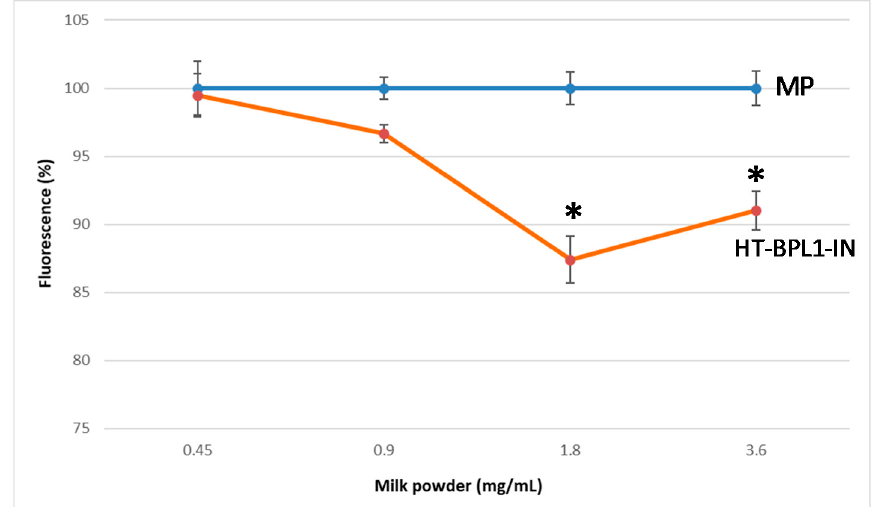
Figure 1. Milk powder supplemented with heat-treated BPL1 (HT-BPL1-IN), reduced fat deposition in C. elegans measured as fluorescence with red Nile, in a concentration-dependent manner. Worms were incubated for 3 days with increasing concentrations (abscissa) of milk powder alone (MP) or milk powder supplemented with HT-BPL1-IN. Data are means ± SD of 120 worms assayed in a prototype experiment. * p < 0.001 with respect control.